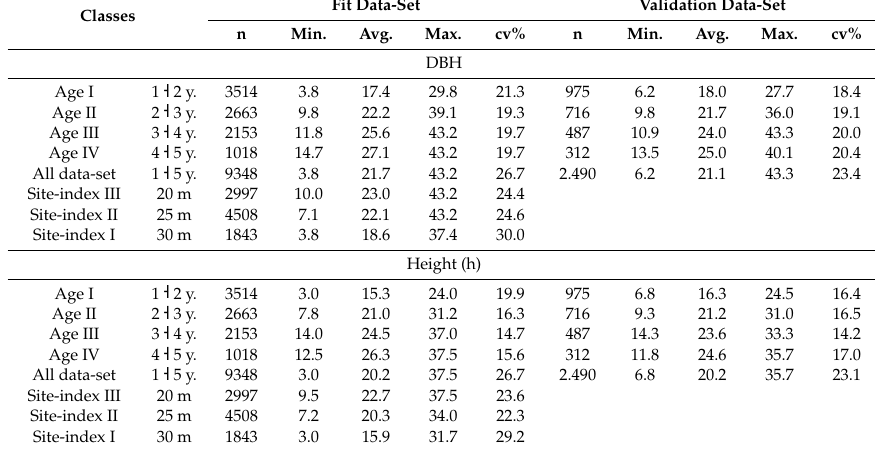
Table 1. Descriptive statistics of height–diameter variables in the fit and validation data-sets of Ochroma pyramidale (balsa-tree) stands in Ecuador. Classes Fit Data-Set